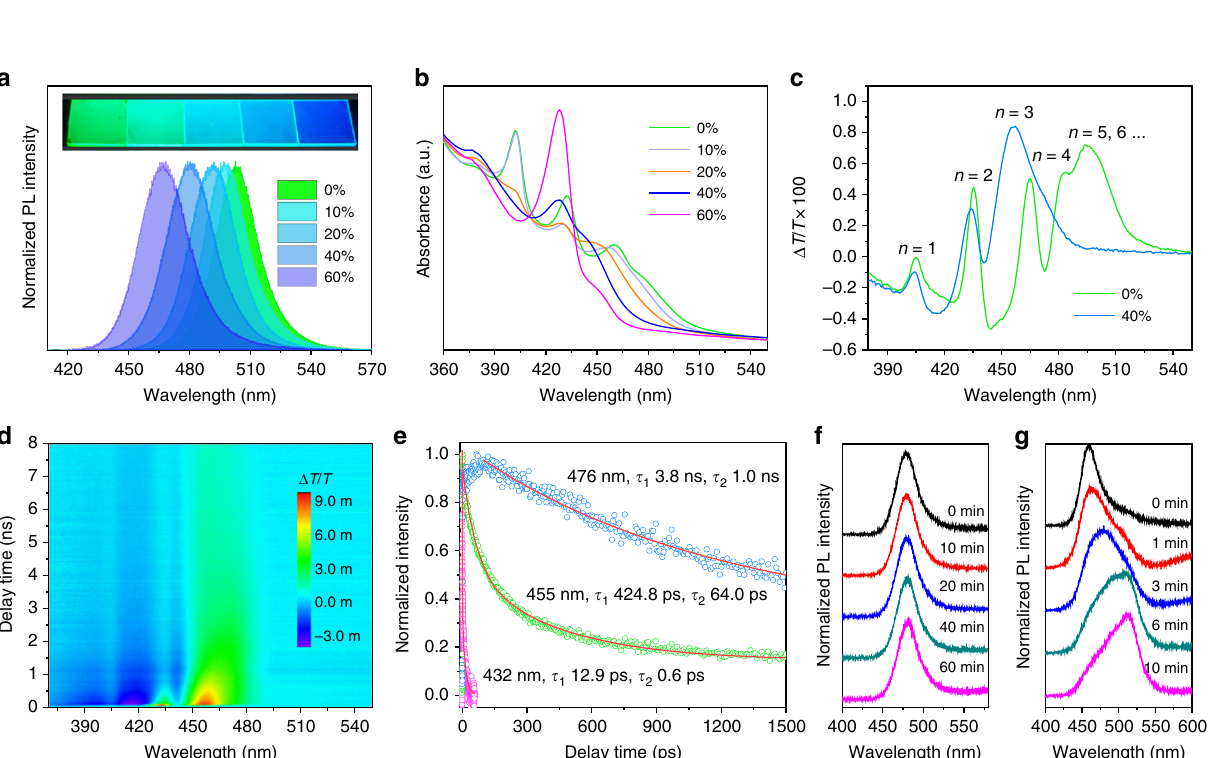
The ratio of the precursors is mole ratio. Sample I is the control sample